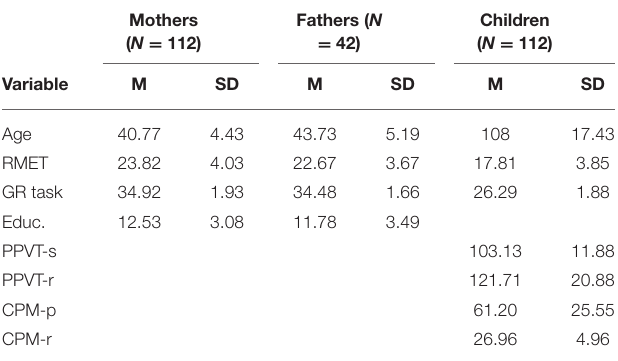
TABLE 4 | Partial correlations between RMET-C, mother’s education, father’s education, mother’s performance on RMET, and father’s performance on RMET, controlling for children’s